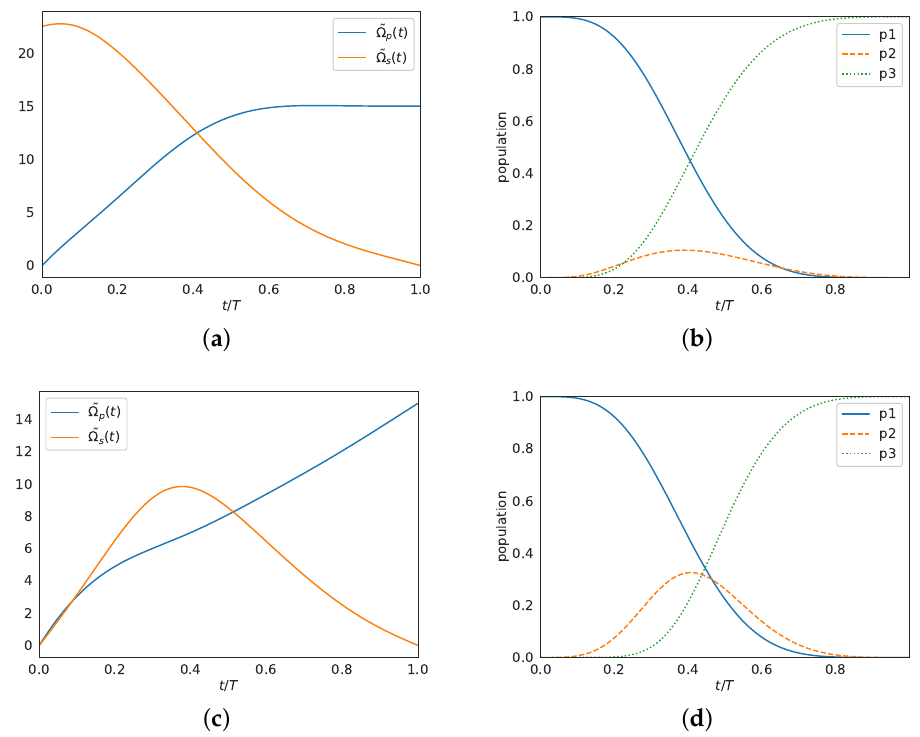
Figure 1. ( a ) Pump and Stokes pulses (in units T − 1 ) for the shortcut to adiabaticity where the mixing angle is a polynomial function of time and Ω ( t ) = Ω 0 is a constant. ( b ) Corresponding time evolution of the level populations. ( c , d ) Controls (in units T − 1 ) and populations for the case where Ω ( t ) = Ω 0 t / T is a ramp. In both cases, the value Ω 0 = 15 T − 1 is used.